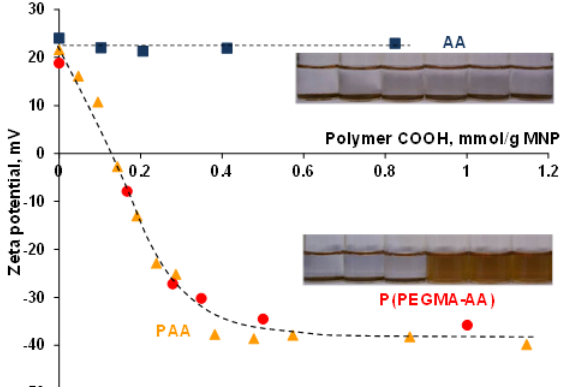
Figure 4. Zeta potentials of coated nanomagnets as a function of P(PEGMA-AA) (red), PAA (orange) [37], and AA (blue) loadings, calculated on the basis of molar amount of carboxylic groups (0–1.2 mmol/g). The measurements are done at pH ~ 6.5 and I = 10 mM (NaCl).